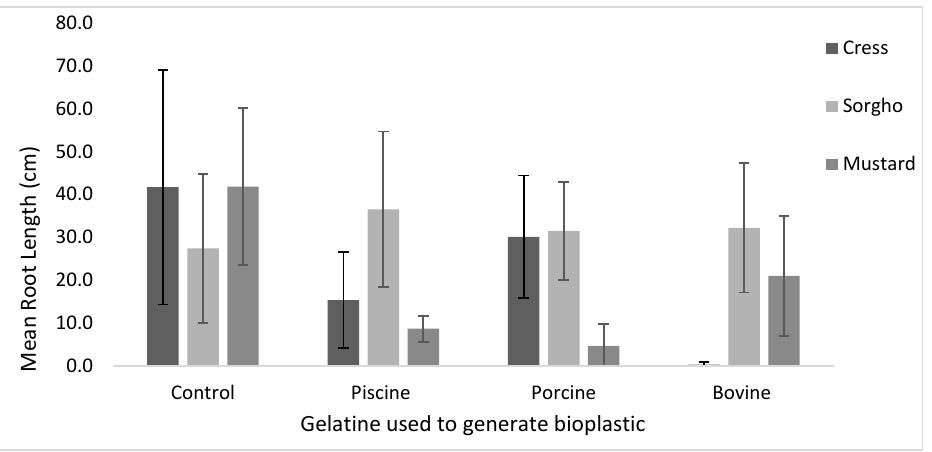
Table 1. Root length of seeds germinated in soil with different treatment. (n = 10).